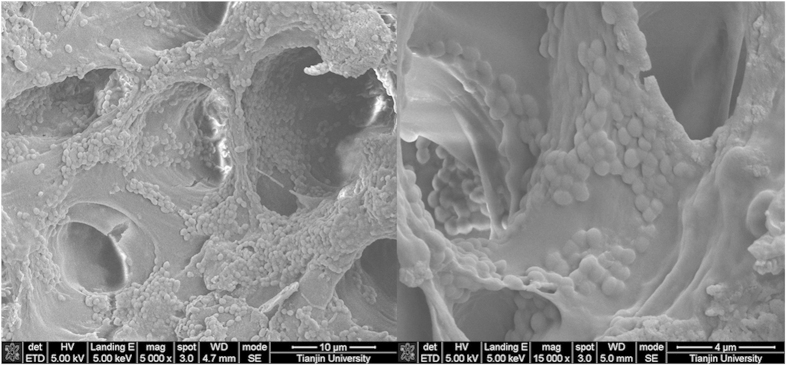
Scanning electron micrograph showing colonization of the root canal walls by E. faecalis (left: 5000× , right: 15000× ).